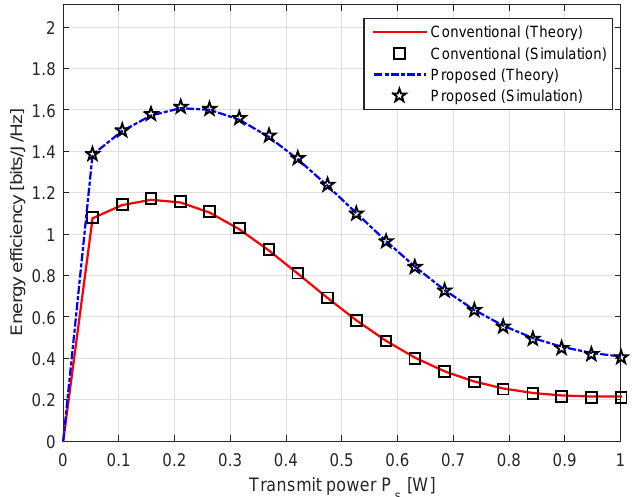
Figure 6. The energy efficiency with the conventional linear and the proposed nonlinear EH